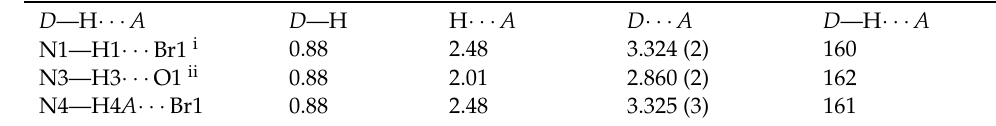
Table 6. Hydrogen-bond geometry (Å, ◦ ) for (IV).